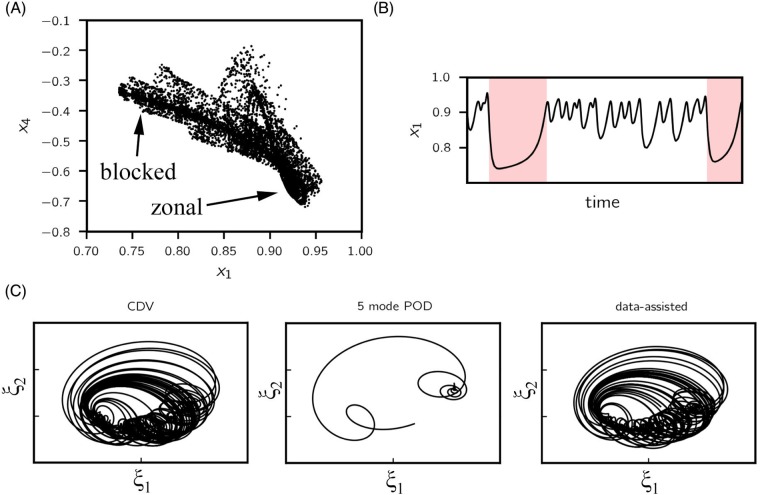
CDV system.(A) 104 points sampled from the CDV attractor, projected to (x1, x4) plane. (B) Example time series for x1; blocked flow regime is shaded in red. (C) Length-2000 trajectory projected to the first two POD modes (normalized) integrated using the CDV model (left), 5-mode POD projected model (middle) and data-assisted model (right). Despite preserving 99.6% of the total variance, the 5-mode projected model has a single fixed point as opposed to a chaotic attractor. Data-assisted model, however, is able to preserve the geometric features of the original attractor.